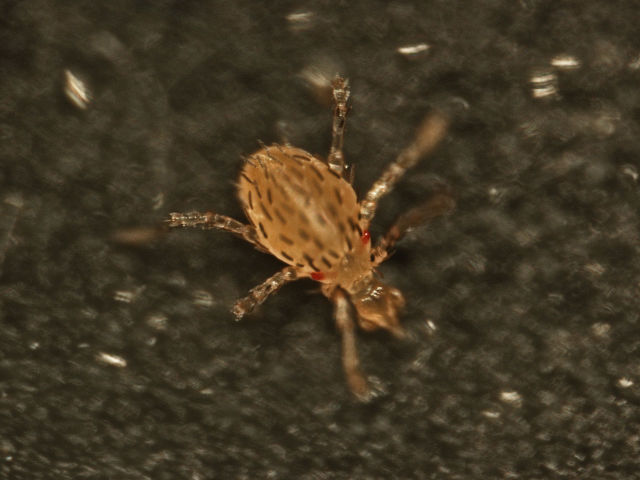
Leptus sp. Photo Joanna Mąkol.